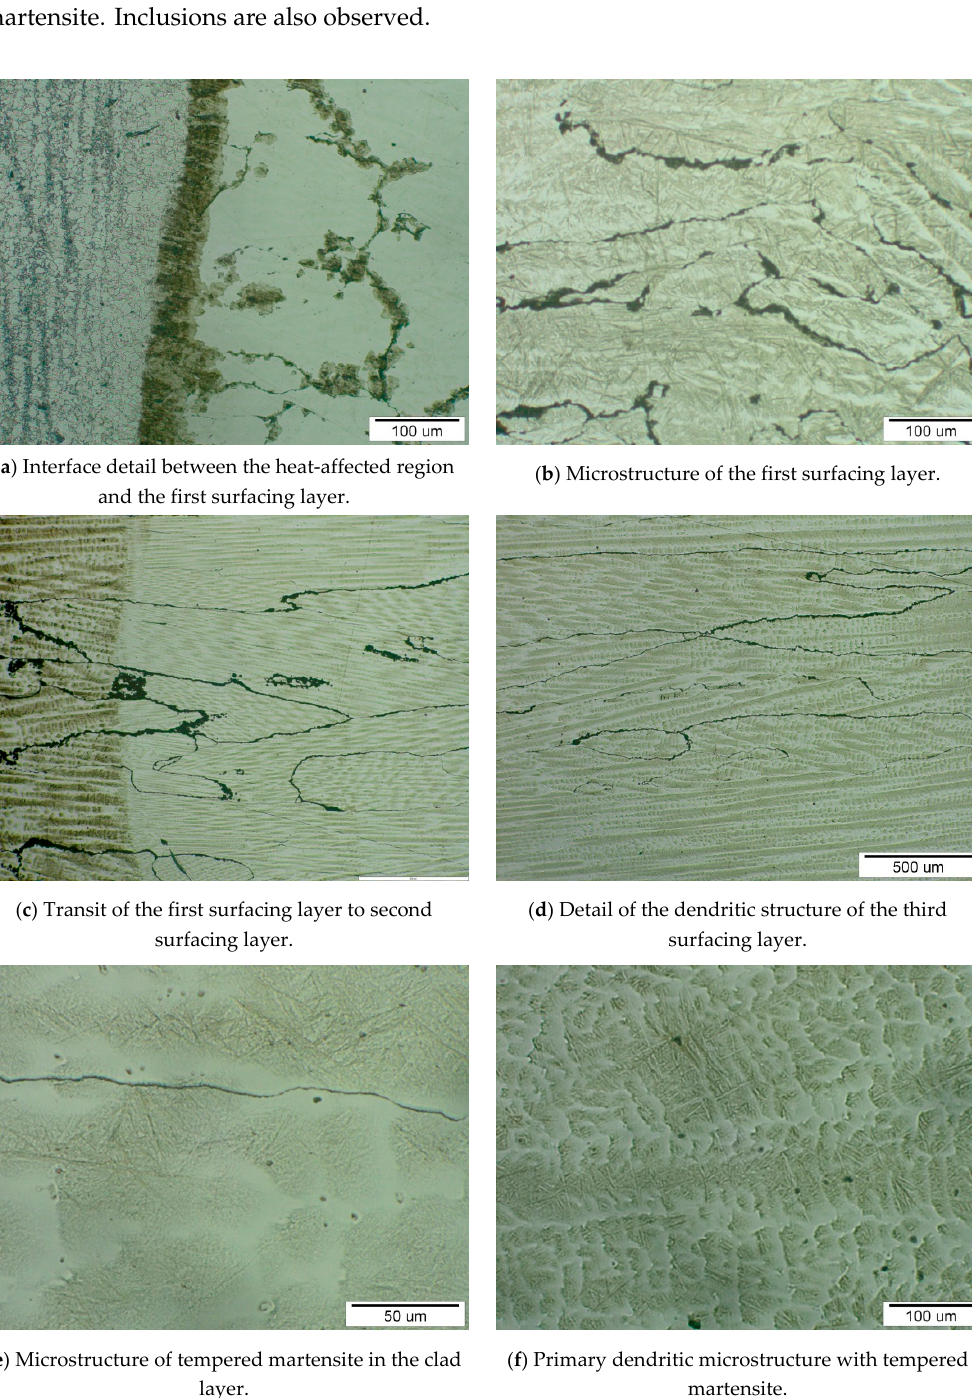
Figure 3. Microstructure of surfacing layer B2.